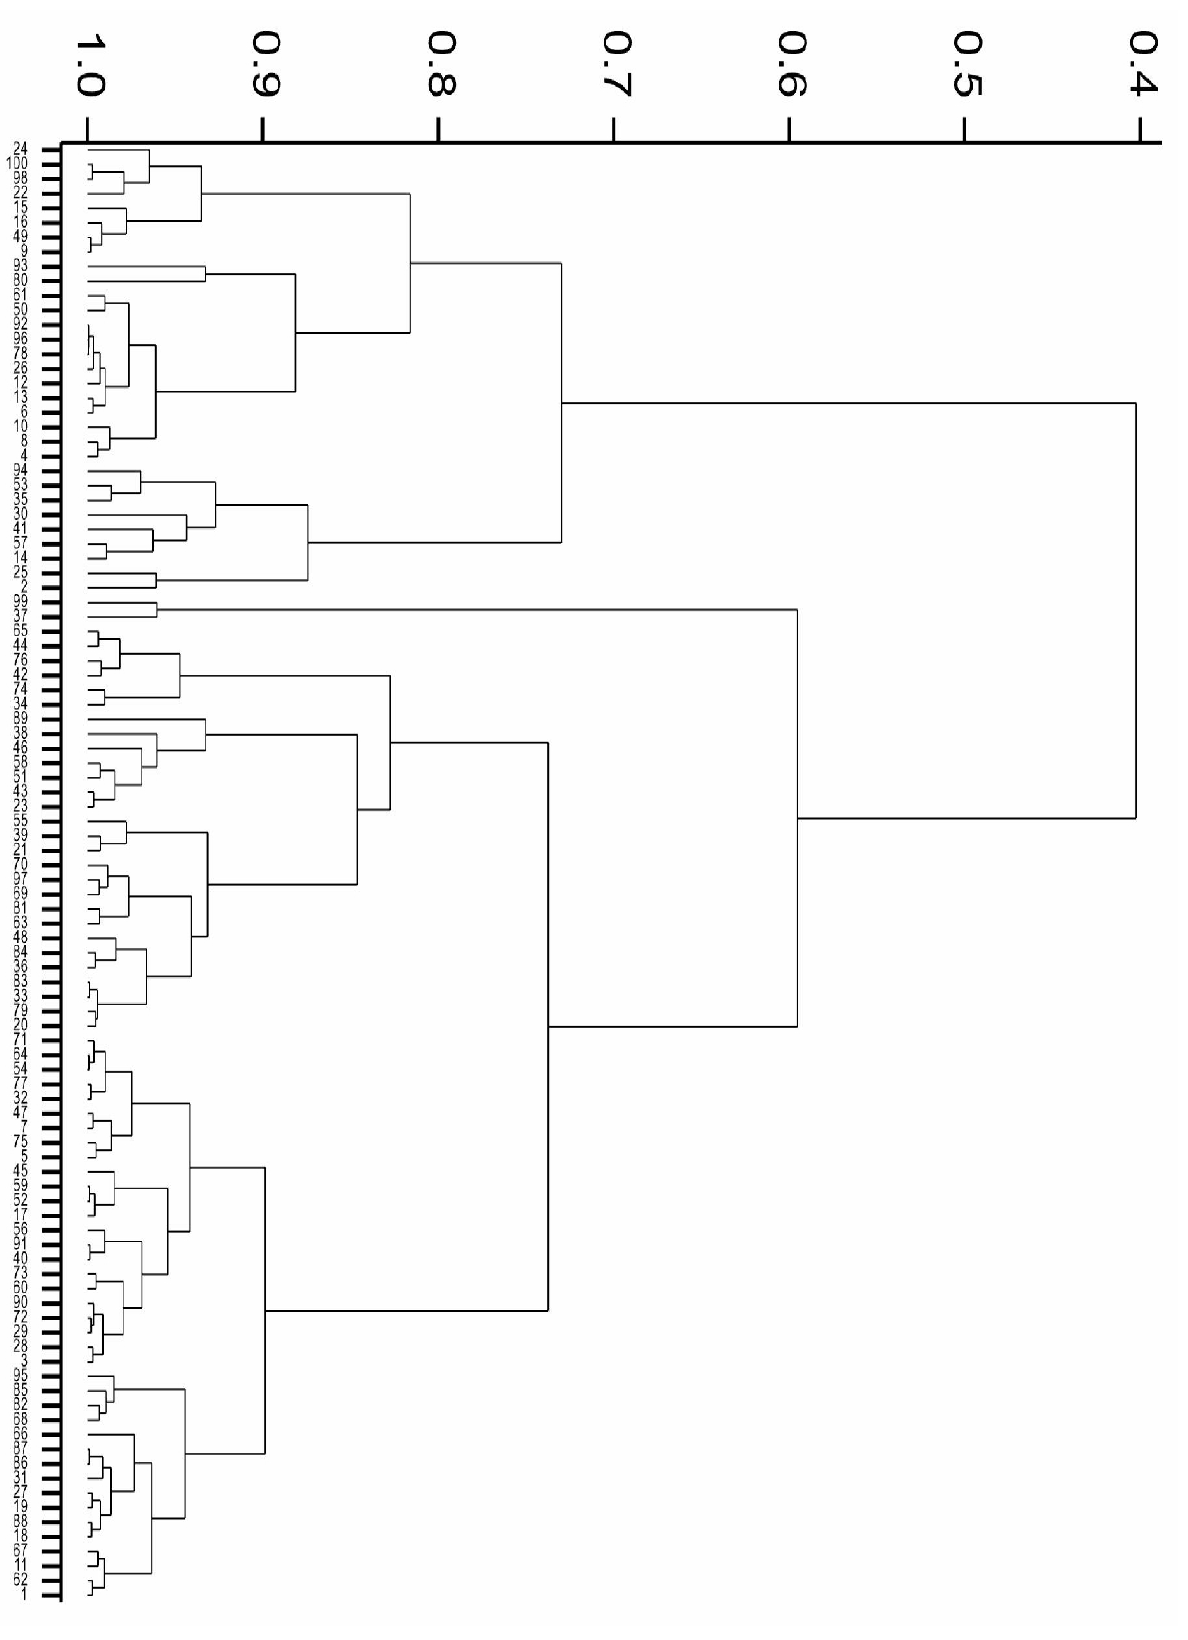
Figure 3. Dendrogram of sorghum accessions based on average linkage of five biochemical traits.